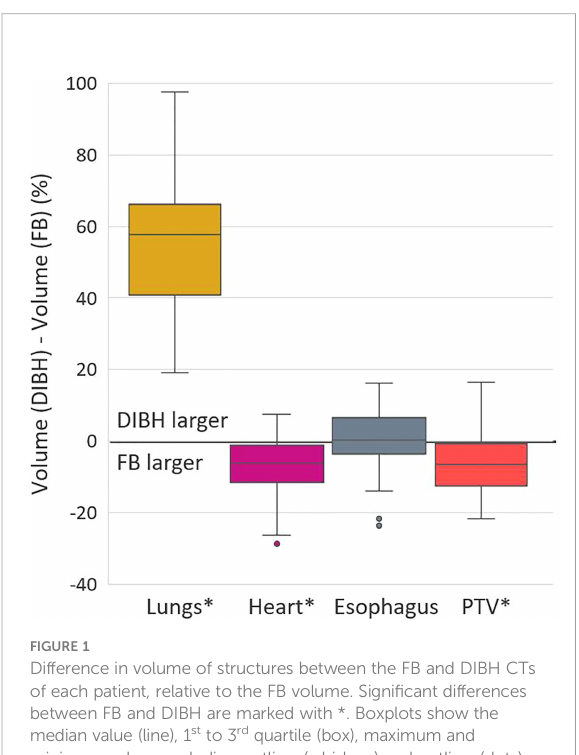
TABLE 1 Patient and treatment characteristics.